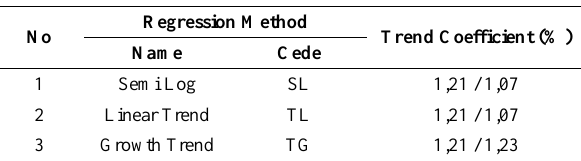
Table 3. Test coefficient